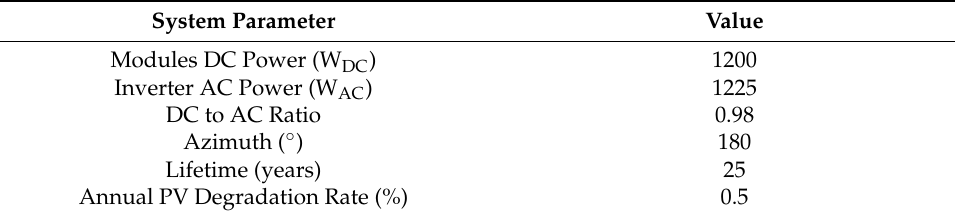
Table 1. Parameters used in the PV system energy production simulation in